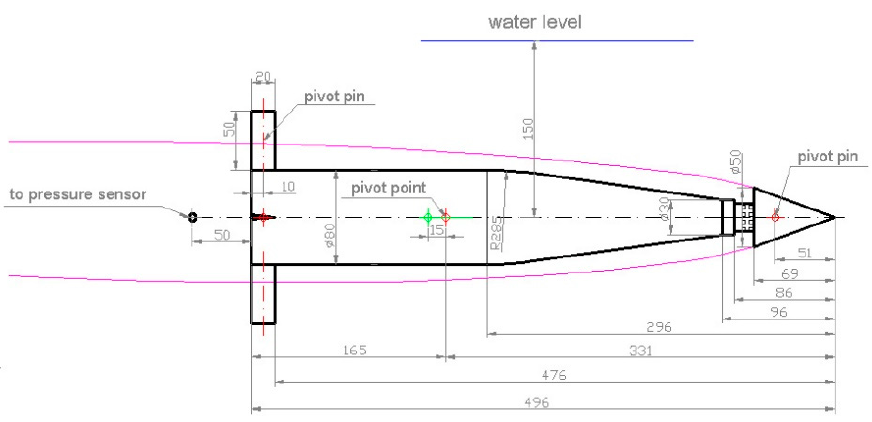
Figure 7. Small-scale supercavitating vehicle.